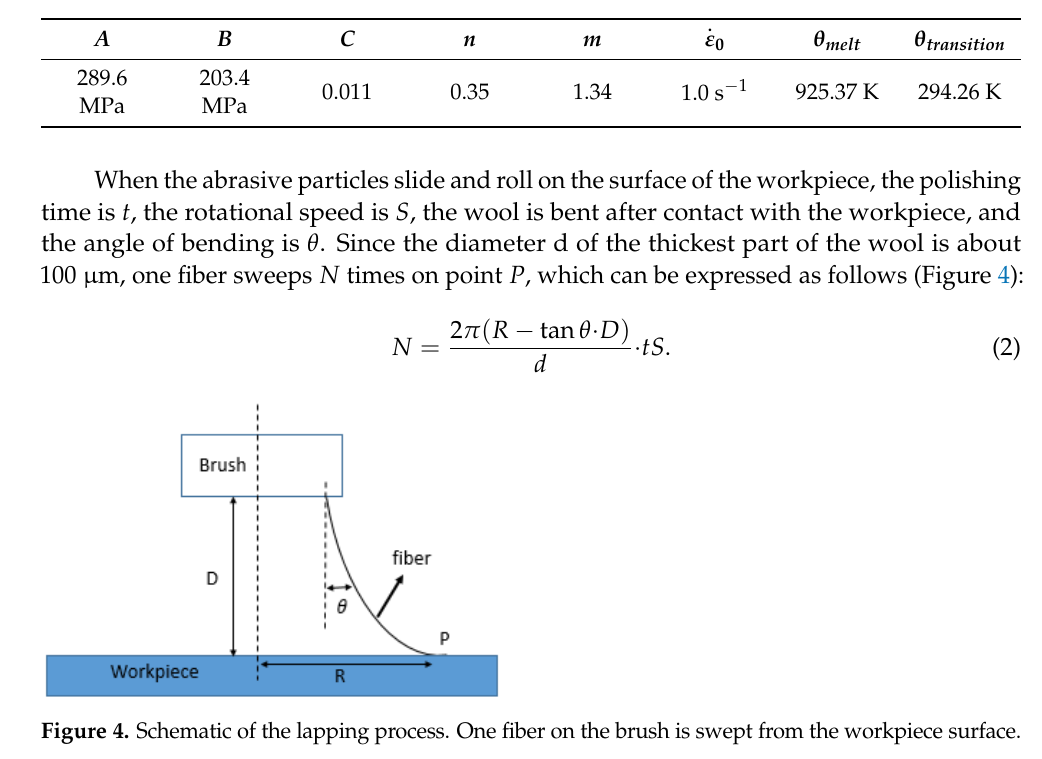
Table 2. Johnson Cook coefficients.